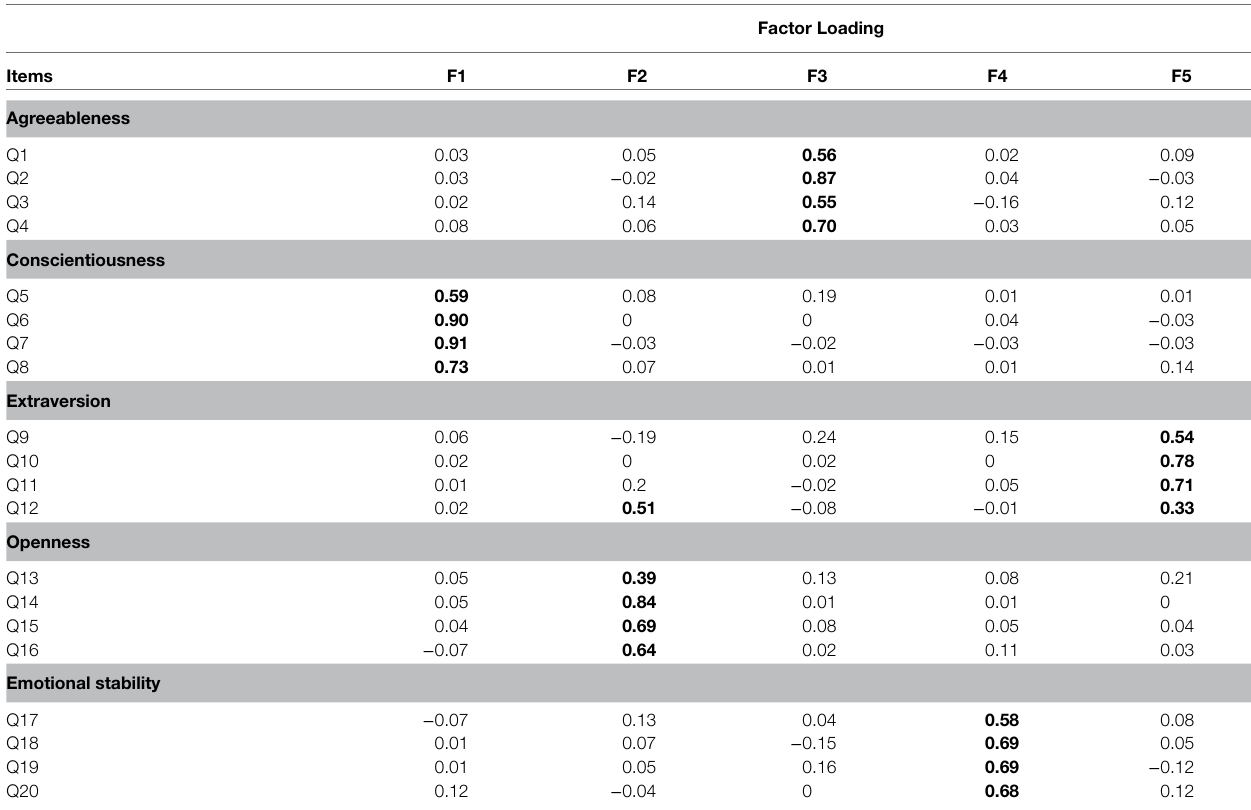
TABLE 1 | Results of the EFA on the Chinese version of the ORG-B5 in Study 1.